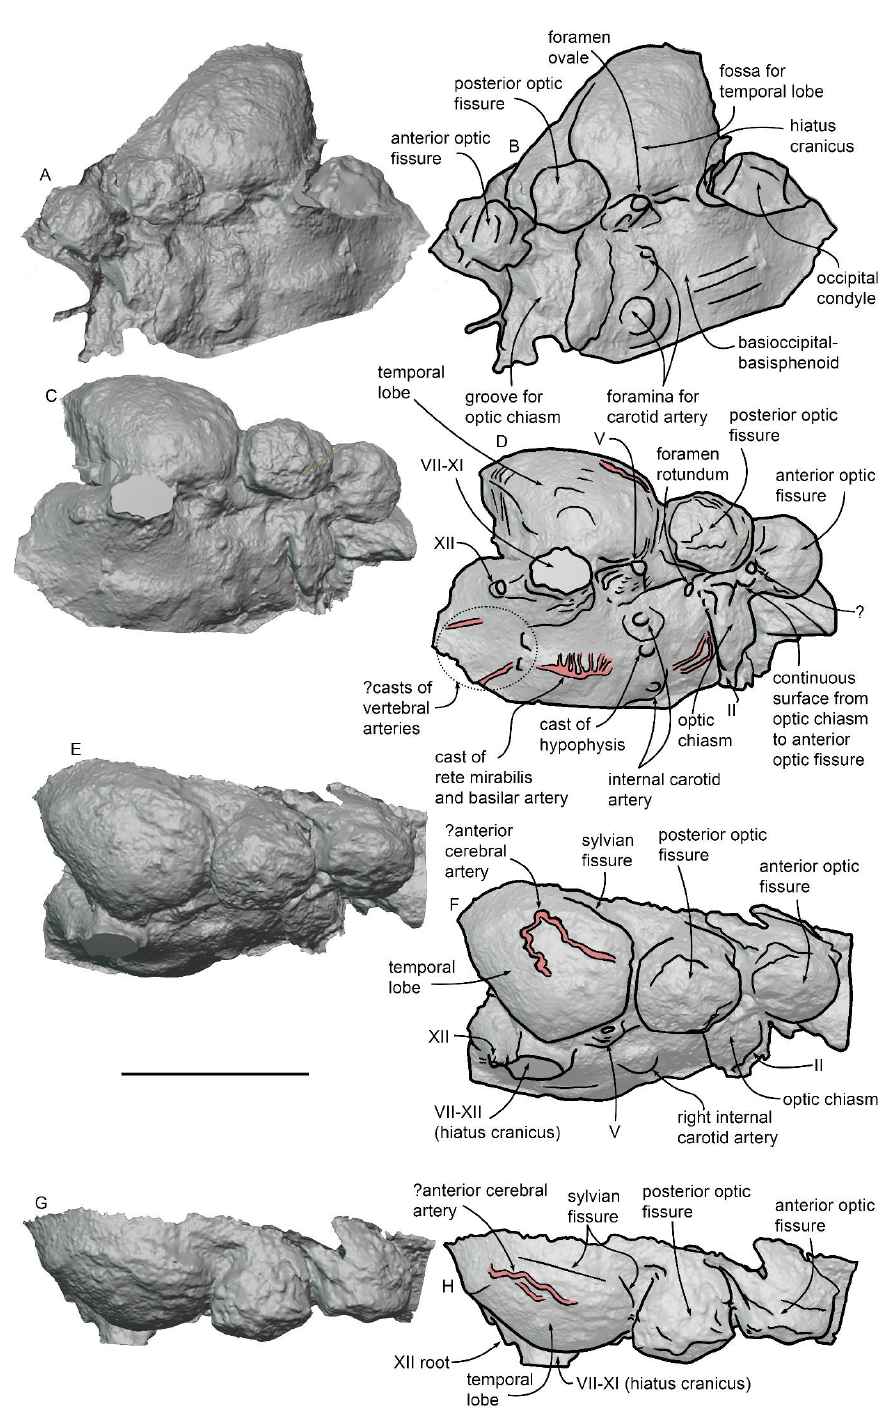
Figure 15. Virtual endocast of MGPT-PU 13881/1. ( A ) Software representation of the dorsolateral view of the basicranium. ( B ) Anatomical interpretation of ( A ). ( C ) Software representation of the ventral surface of the brain in the virtual endocast in ventral view. ( D ) Anatomical interpretation of ( C ). ( E ) Software representation of the ventral surface of the brain in the virtual endocast in ventrolateral view. ( F ) Anatomical interpretation of ( E ). ( G ) Software representation of the ventral surface of the brain in the virtual endocast in lateral view. ( H ) Anatomical interpretation of ( G ). Scale bar equals 5